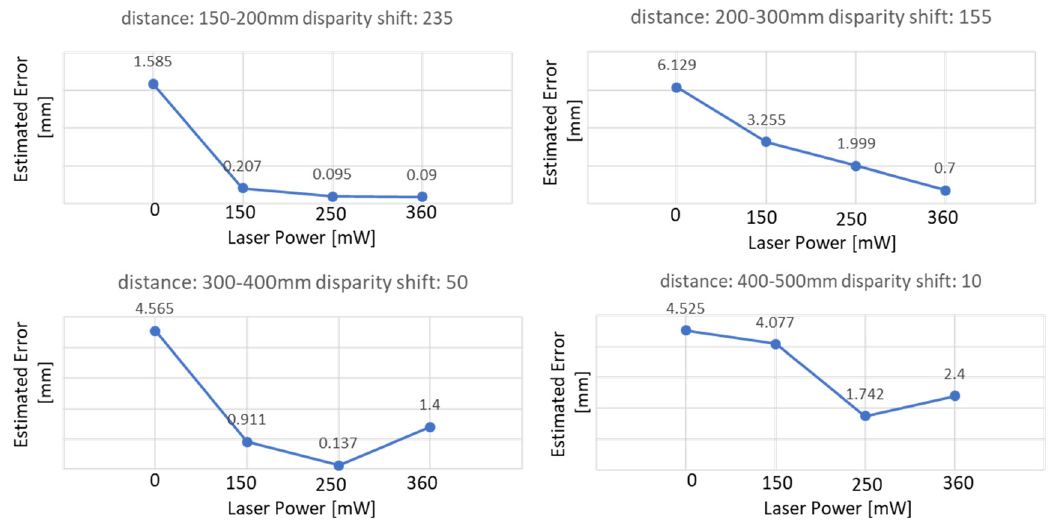
Figure 9. The errors in the estimation of the calibrated sphere for each sub-range from 150 to 500 mm, evaluated for increasing the value of the laser power (0 to 360 mW)